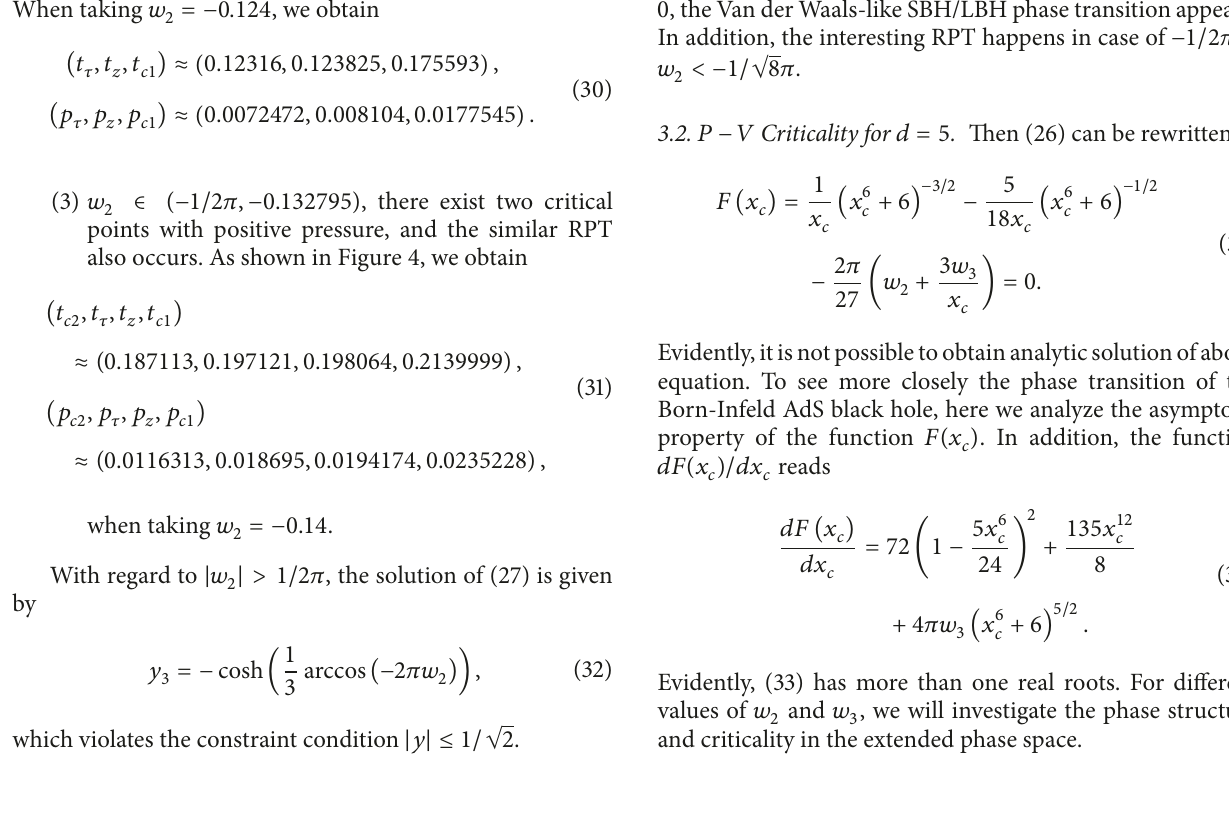
For 𝑝 < 𝑝 𝜏 only one phase of large black holes